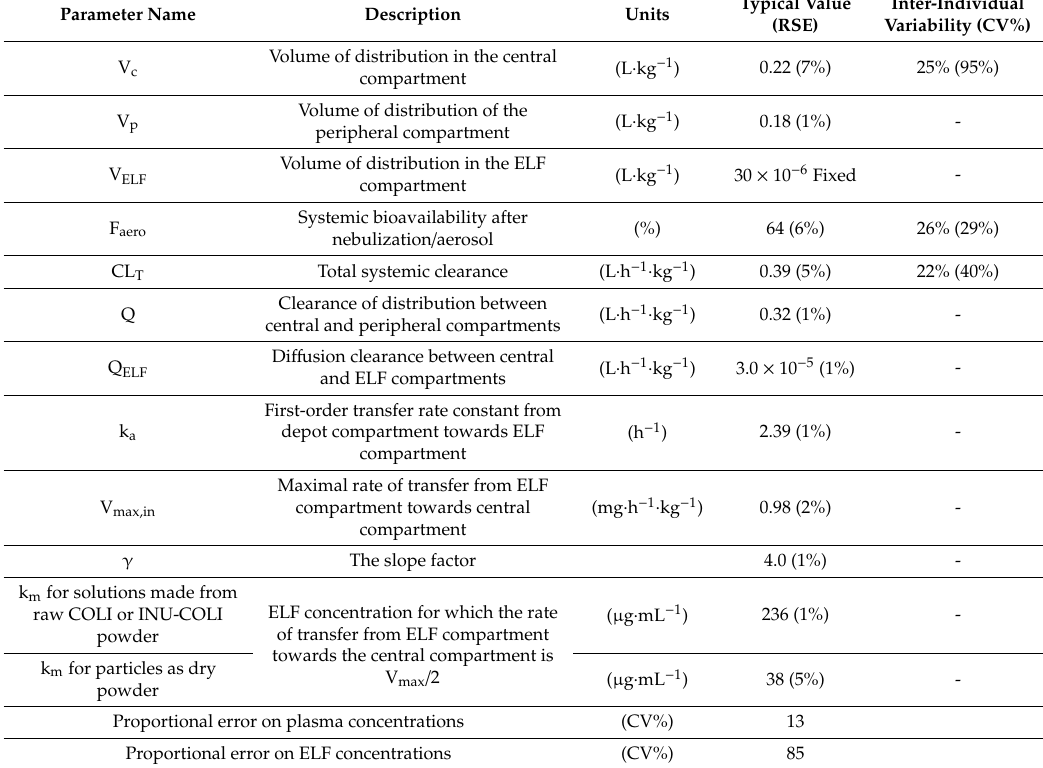
Table A1. Estimation of PK parameters after nebulization of colistin (COLI) at dose of 0.35 mg · kg − 1 as a solution, as INU-COLI dry powder and as solution made by dissolving the INU-COLI powder. Excepted for the K m values, which were significantly di ff erent between solutions and powder COLI formulations, all other parameters were non-significantly di ff erent between the formulations. CV%: Coe ffi cient of Variation expressed in